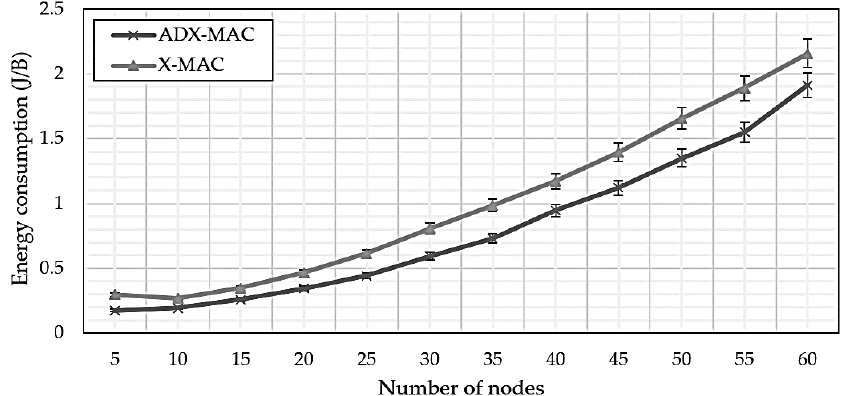
Figure 9. ADX-MAC and X-MAC energy consumption for an individual byte transmitted until the simulation completed.